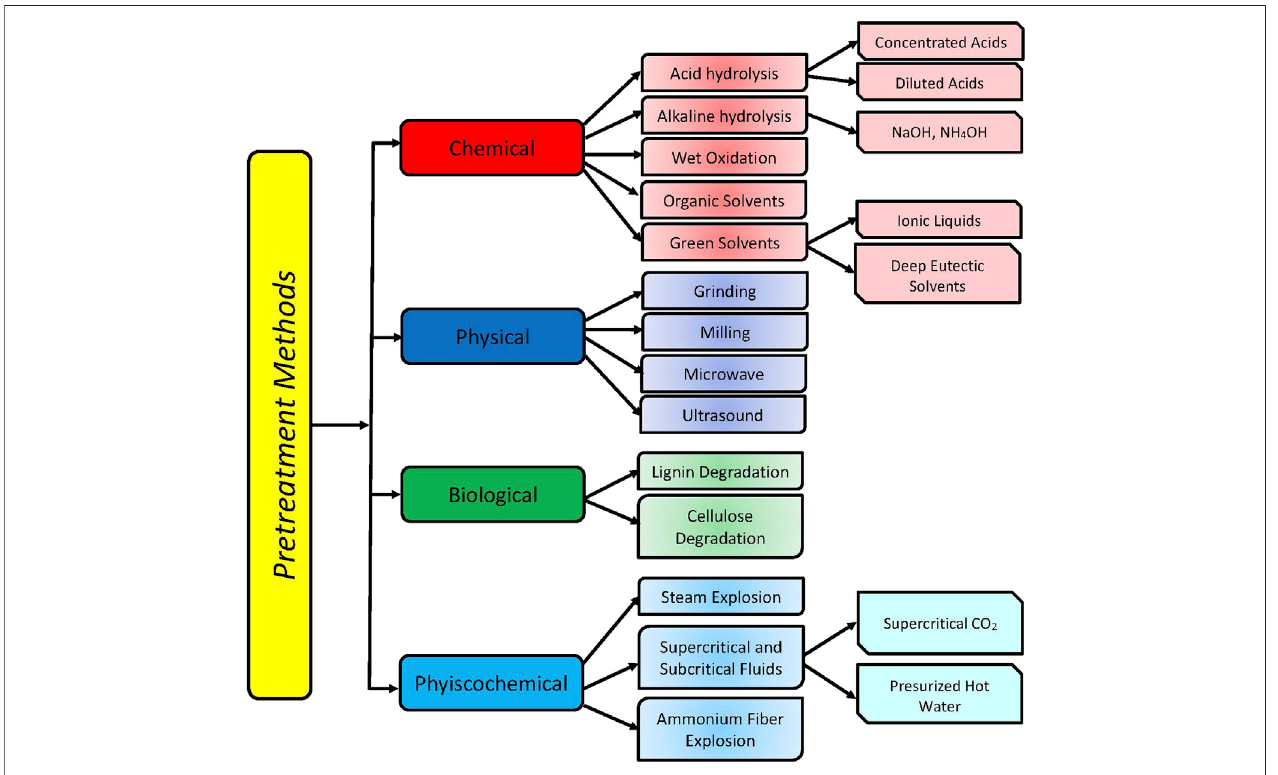
FIGURE 5 | Classi fi cation of biomass pretreatment